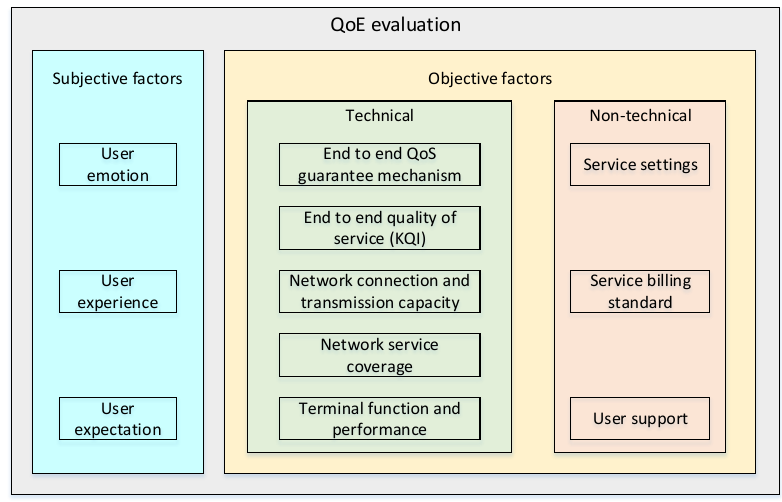
Figure 1. The Classification of QoE (Quality of Experience) influencing factors for video streaming service.